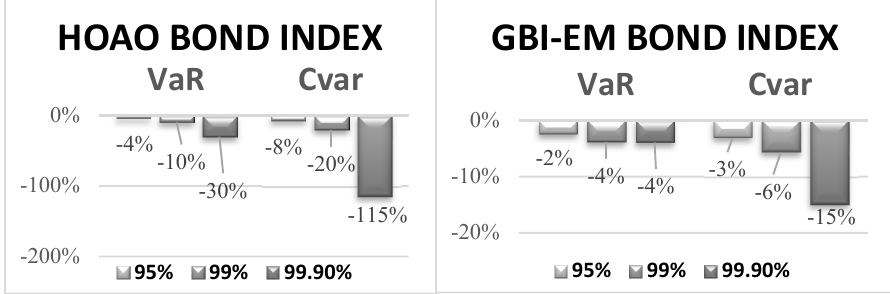
Figure 3. VaR and CVaR for HOAO and GBI-EM Bond Index Asset Class.